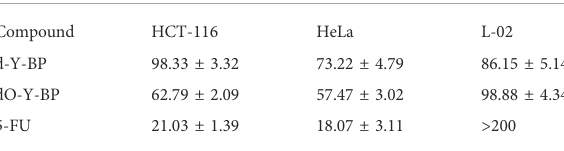
TABLE 2 The half-maximum inhibitory concentration (IC 50 ) of d/dO- Y-BP and 5-FU on HCT-116, HeLa, and L-02